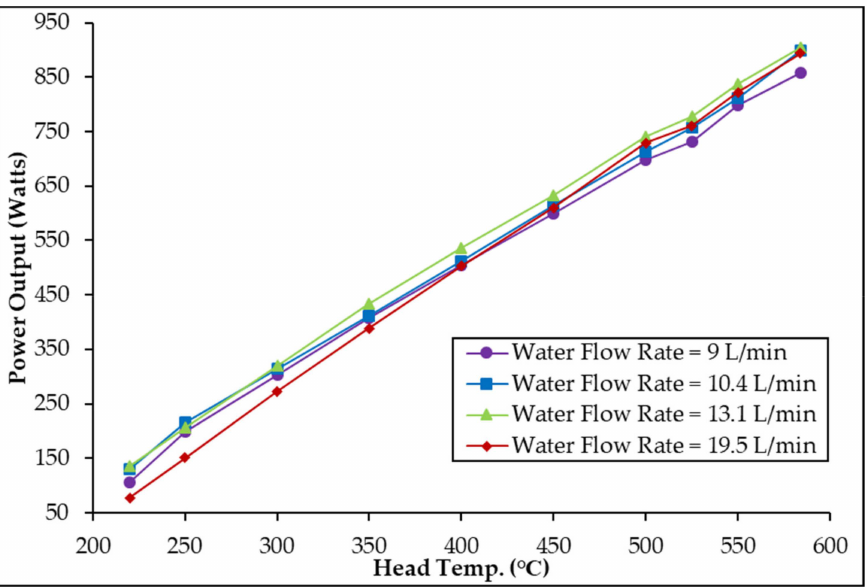
Figure 3. Power outputs at various head temperatures and water flow